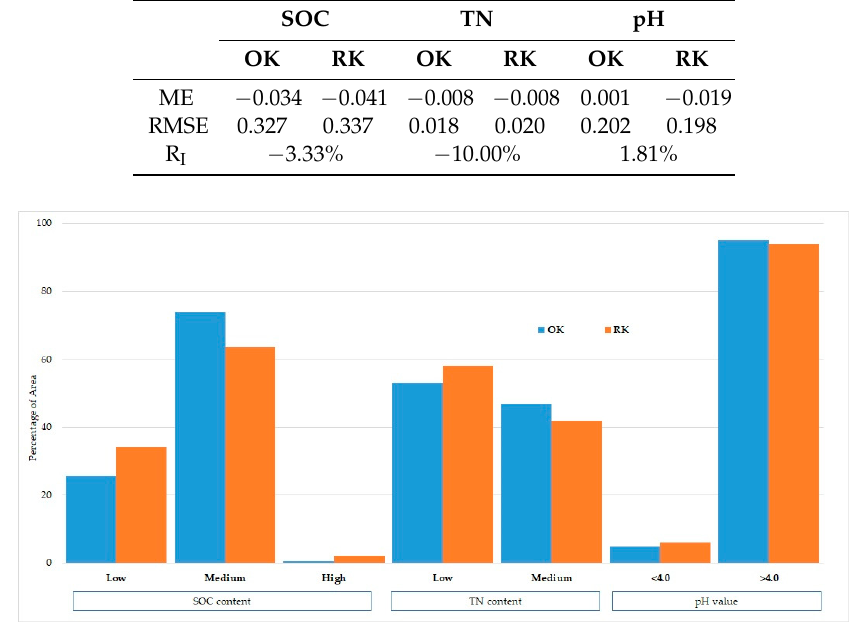
Table 4. Accuracy assessment of ordinary kriging (OK) and regression kriging (RK) method for SOC, TN, and pH mapping.